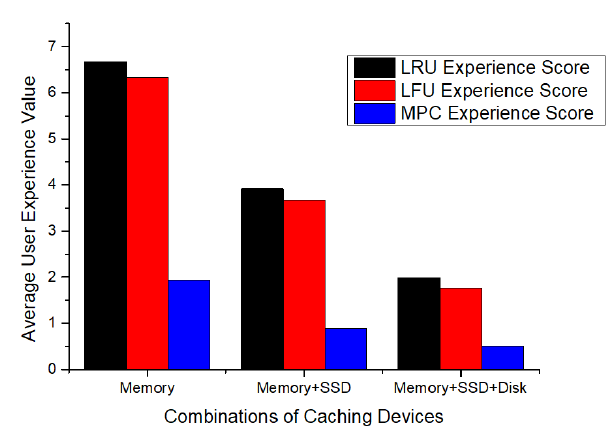
Fig. 5 The effect of caching device on user experience. LRU, least recently used; LFU, least frequently